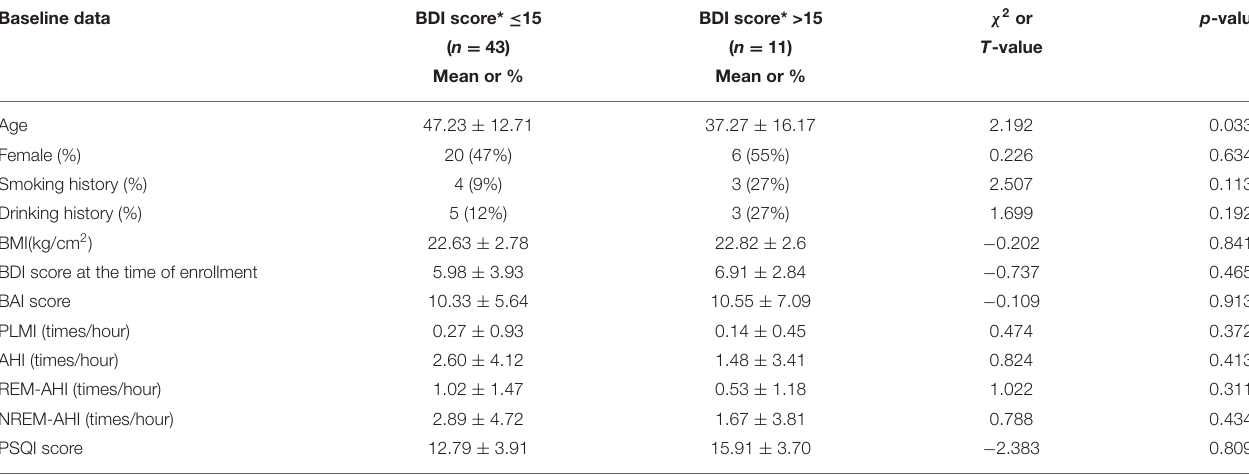
TABLE 1 | Baseline characteristics of 54 SID patients (BDI score classification after 3 months of follow-up). Baseline data